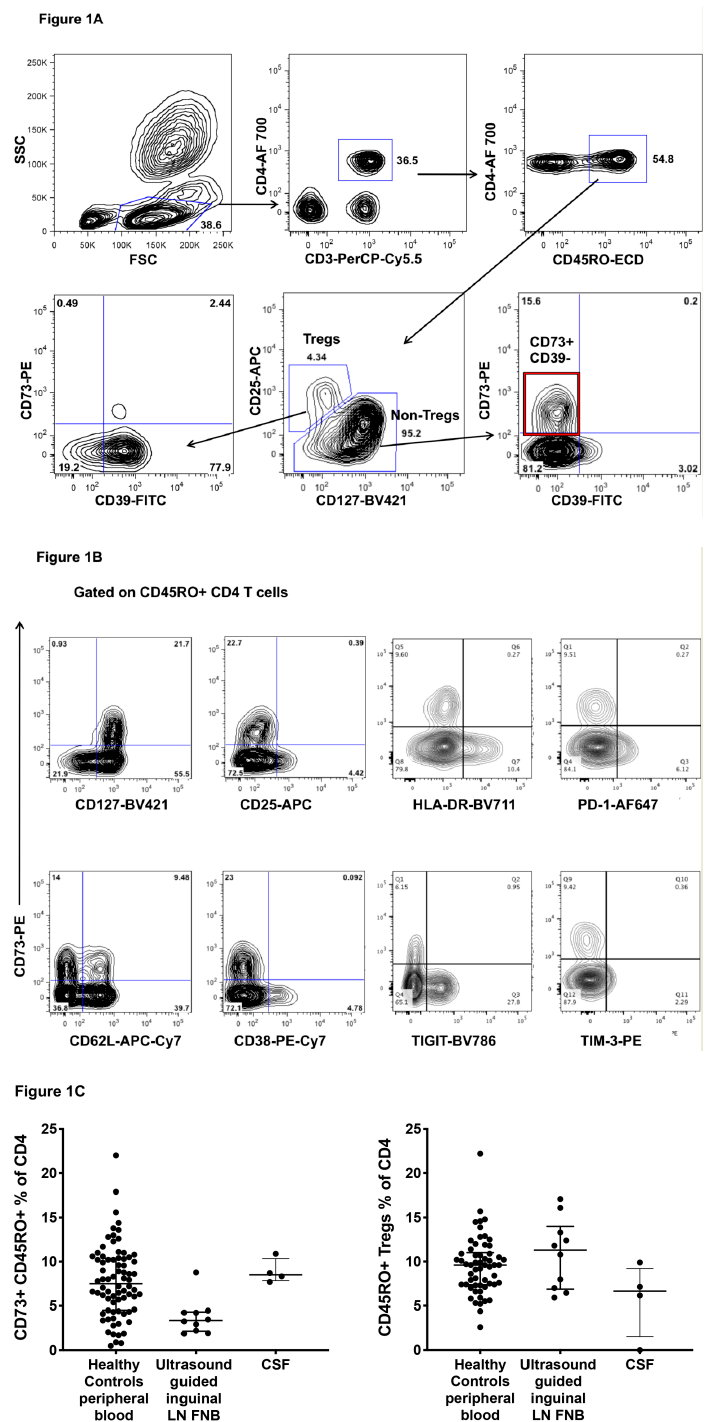
Figure 1. CD73+ CD4+ T cells. ( A ) Representative flowplots showing expression of CD73 on CD45RO+ memory CD4+ CD3+ lymphocytes, on the non-Treg subset (bottom right flow plot) when Tregs are gated as CD25 high CD127 dim . Conversely, there is minimal expression of CD73 on Tregs, which are predominantly CD39+CD73 (bottom left flowplot). ( B ) Representative flowplots showing that CD73+ CD45RO+ memory CD4+ CD3+ lymphocytes are almost exclusively CD127 high , CD25 low , CD38 low , HLA-DR low , TIGIT low , PD-1 low and TIM-3 low , but a mixture of CD62L+ and CD62L-negative cells. ( C ) Summary data for CD73+ cells as a percentage of CD45RO+ memory CD4+ CD3+ T lymphocytes from blood samples from n = 76 healthy adult controls, from ultrasound guided fine needle biopsies of inginual lymph nodes and from cerebrospinal fluid (CSF) samples from HIV+ subjects on antiretroviral therapy (ART).